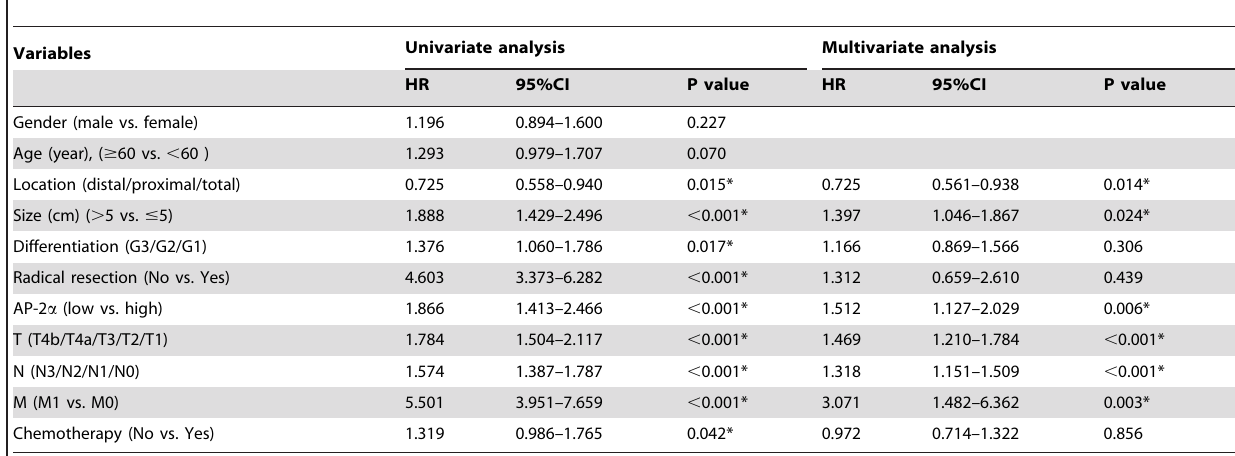
Table 2. Univariate and multivariate survival analysis of clinic-pathologic variables in 481 cases of gastric carcinoma patients.